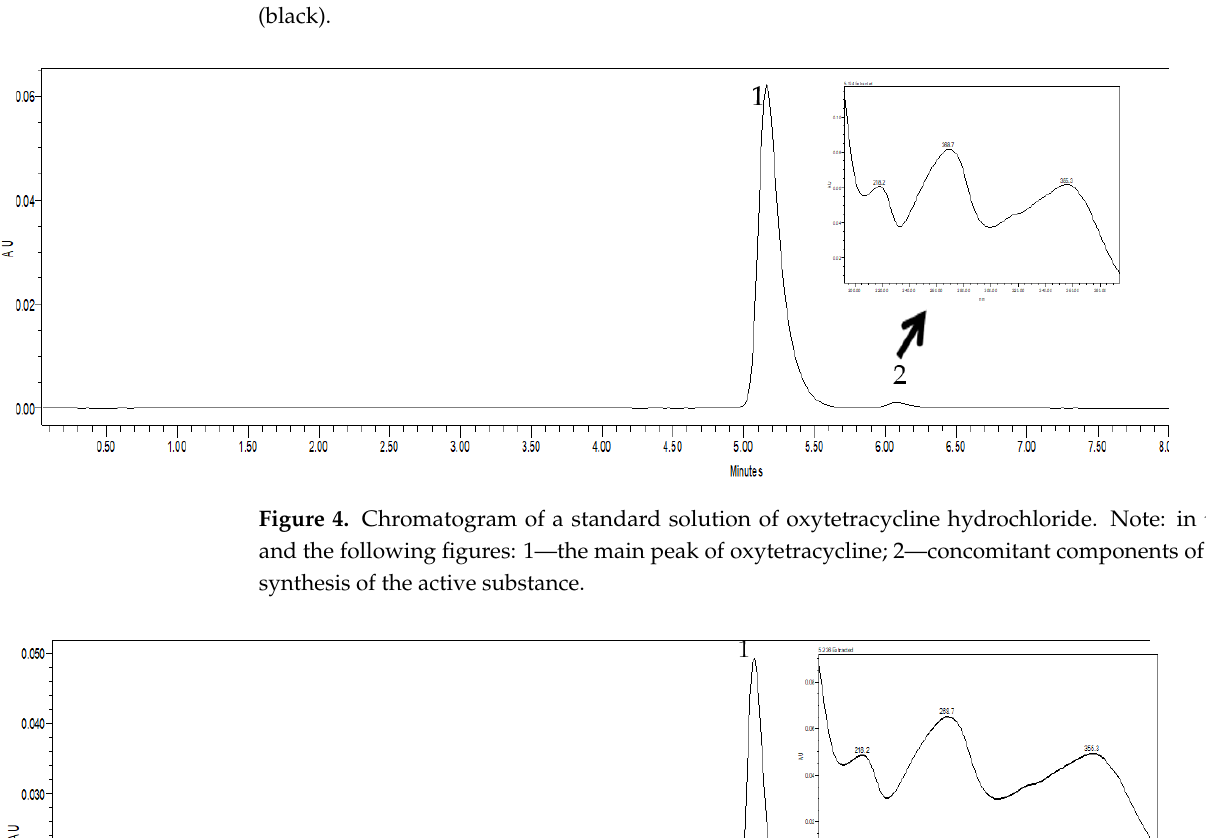
Figure 3. Chromatograms of polyphosphate ester-type transporters: P4 and P6. * Note: P4 (green), P6 (black).